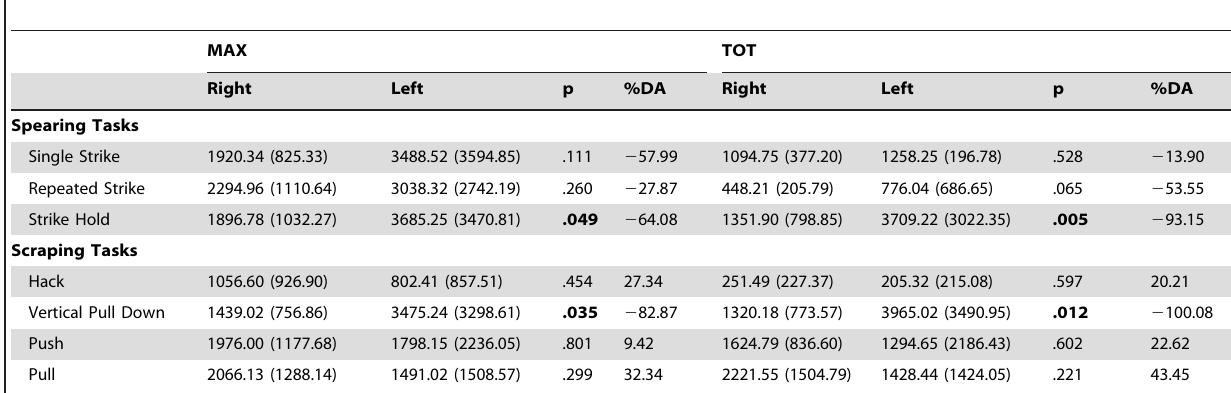
Table 3. Bilateral posterior deltoid maximum (MAX) and total (TOT) muscle activity for all scraping and spearing tasks.